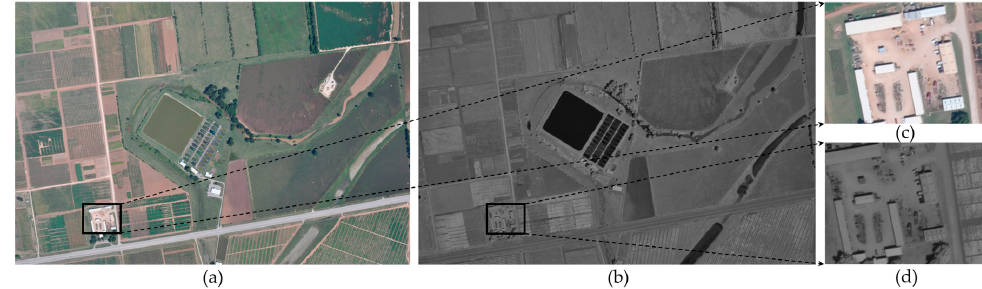
Figure 3. Global Image Set II and Local Set II: images near College Station, Texas, USA. ( a ) Global RGB visible image; ( b ) Global NIR image; ( c ) Local RGB visible image; and ( d ) Local NIR image. The Local Set images contained 400 × 300 pixels extracted from the same area on the corresponding Global Set images.